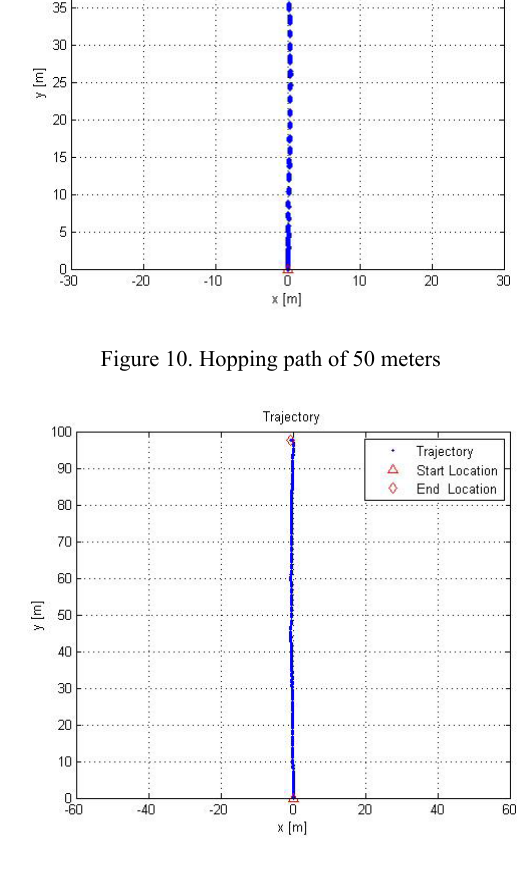
Figure 11. Hopping path of 100 meters